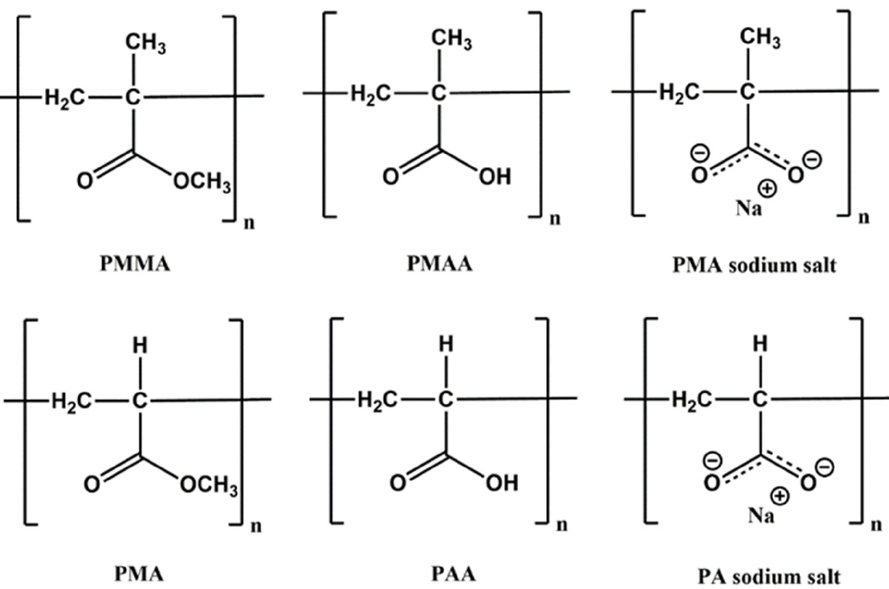
Figure 1. Chemical structures of the poly(acrylic acid) (PAA) and poly(methacrylic acid) (PMAA) and their corresponding sodium salts (PA and PMA sodium salt) and methyl esters (PMA and PMMA).